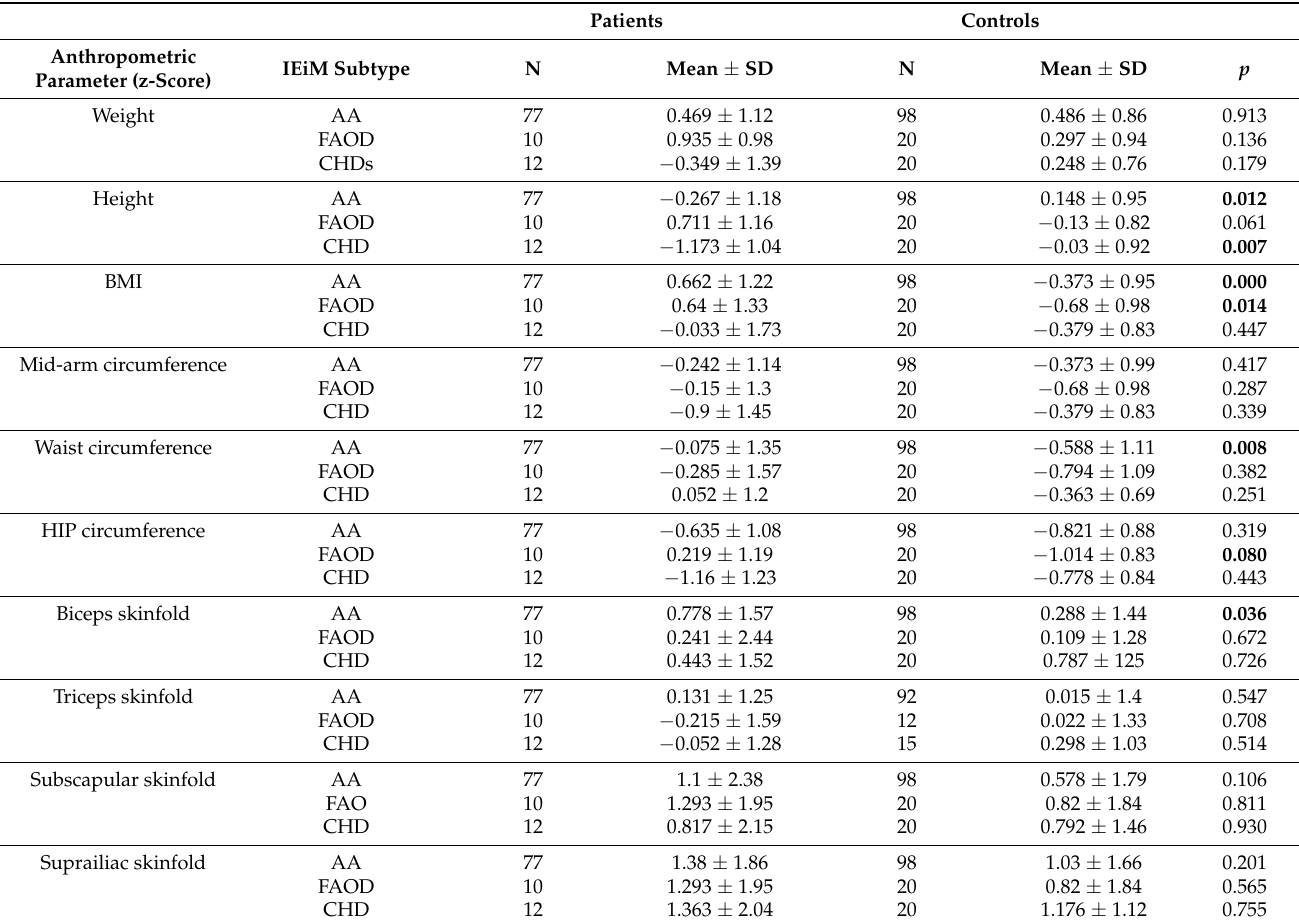
Table 4. Mean body composition z-scores among intermediary metabolism disorders compared with controls.